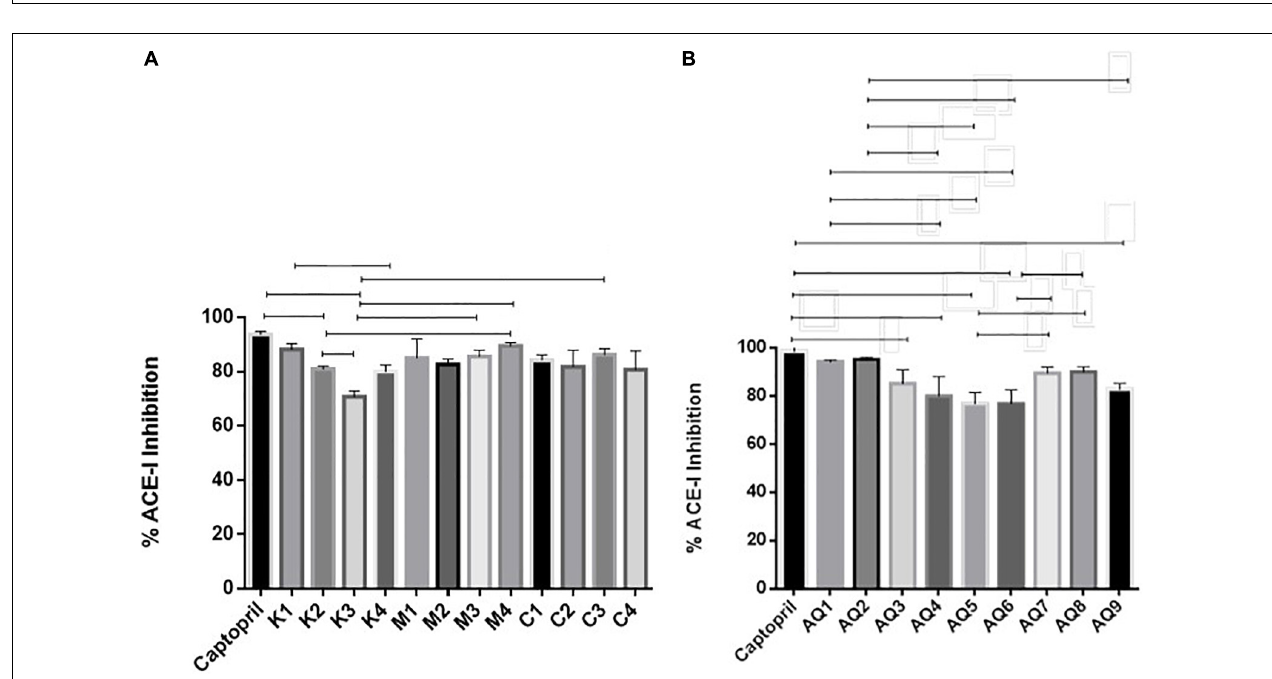
analyzer (LECO Corp., St. Joseph, MI, United States)